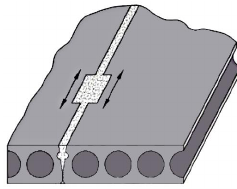
Fig. 5. The arrangement of the keys in the longitudinal edges of the no formwork